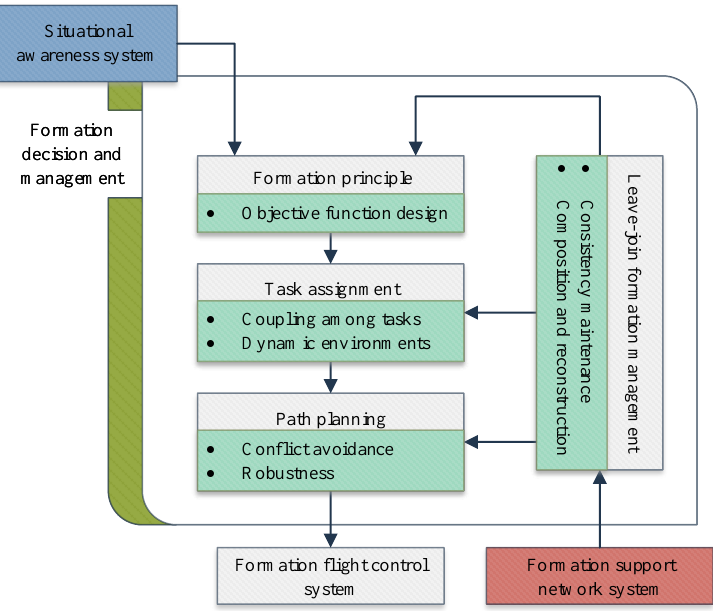
Figure 2. Key technologies in formation cooperative